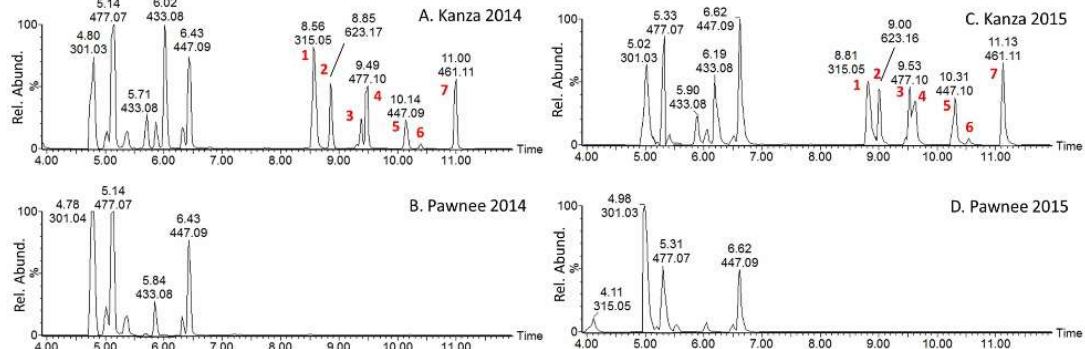
Figure 3. UHPLC-MS extracted ion chromatograms (4 to 12 min) of Kanza ( A , C ) and Pawnee ( B , D ). Samples A (Kanza) and B (Pawnee) were collected in 2014 while C (Kanza) and D (Pawnee) were collected in 2015 from the Noble McMillian Farm Pecan Orchard. The chromatograms were normalized to the highest peak in Kanza. Peaks labeled 1–7 were found mostly in Kanza regardless of sampling year and prioritized for peak annotation through MS/MS.